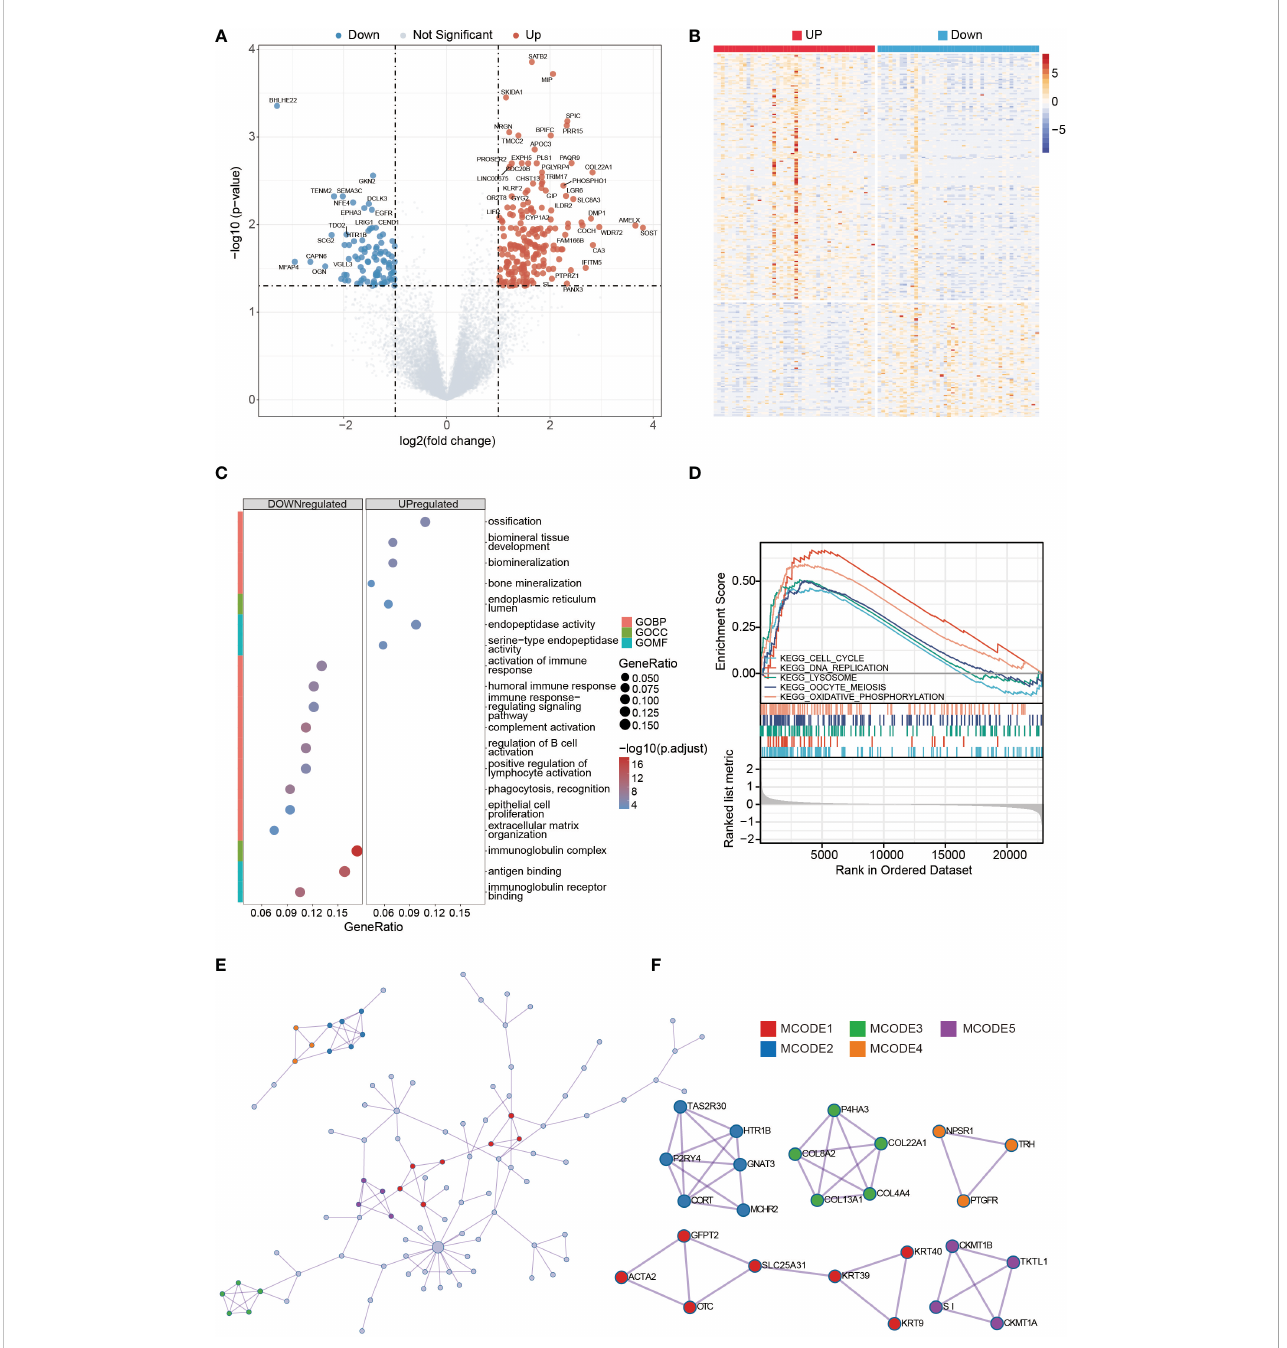
FIGURE 4 DEGs analysis of high- and low-GNG4 expression clusters. GO and GSEA functional enrichment analyses of GNG4, the PPI network, and hub gene cluster construction. (A, B) Grouped in accordance with the median GNG4 value in the TARGET dataset, a total of 224 signi fi cantly different genes were screened, including 127 upregulated and 97 downregulated genes. (C) The GO enrichment method was used to analyse the differentially expressed genes in the high- and low-GNG4 expression clusters. The bubble size represents the amount of gene concentration, and the colour represents the signi fi cance of the difference. (D) GSEA showed enriched genes involved in “ ECM degradation, ” “ collagen, ” “ ECM glycoprotein, ” “ focal adhesion, ” and “ cell cycle ” signalling pathways. (E) PPI networks from the TARGET dataset. (F) Five hub gene clusters were obtained from the TARGET dataset by using the MCODE clustering